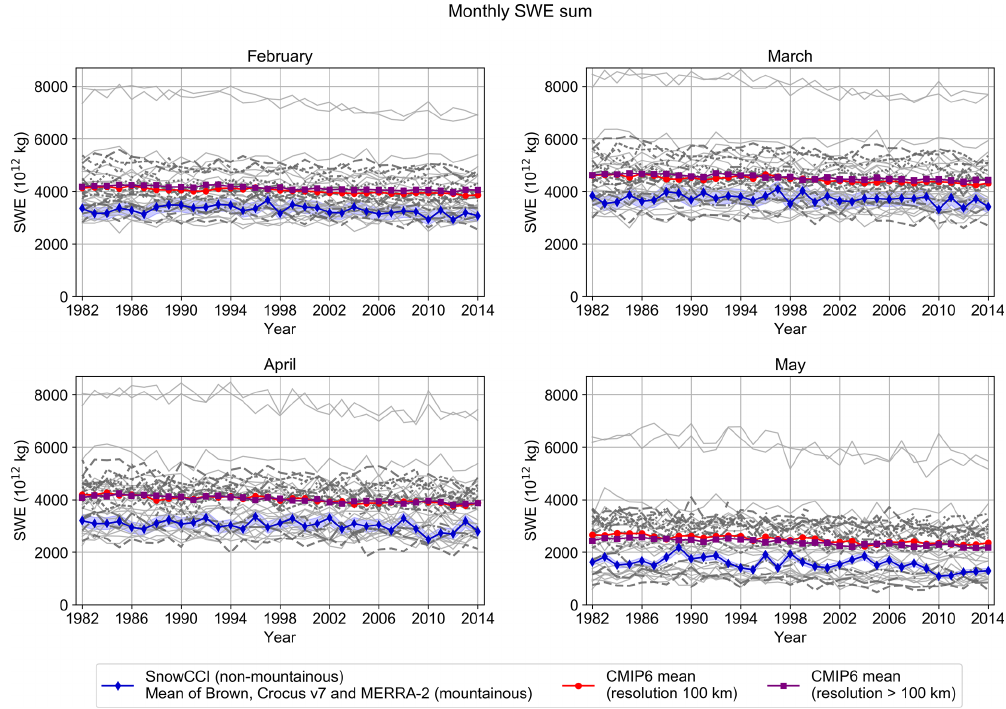
Figure 2. Monthly SWE sum over the entire study area in February, March, April, and May separately for each high-resolution (100km) CMIP6 model (grey dashed lines), for each low-resolution ( > 100km) CMIP6 model (thin solid lines), for the high-resolution CMIP6 multi- model ensemble mean (red markers), for the low-resolution CMIP6 multi-model ensemble mean (purple markers), and for the SWE reference data (blue markers). The blue shaded area indicates the 7.4% uncertainty range of the SWE reference